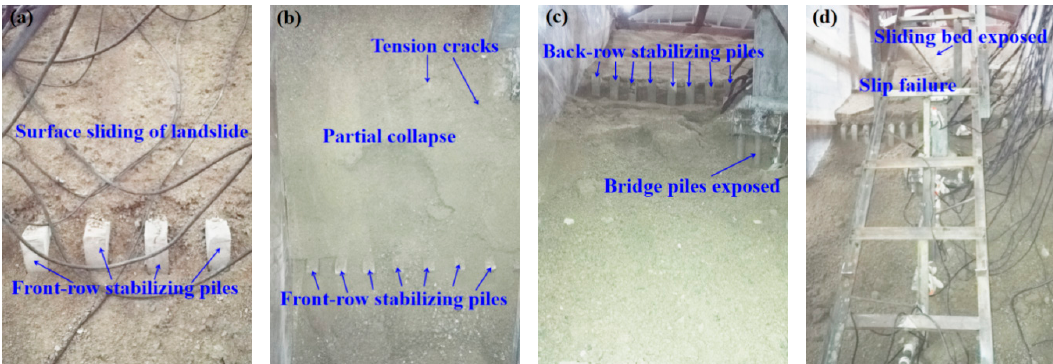
Figure 11. Development process of landslide under the action of vibration wave. ( a ) soil slip on the slope surface; ( b ) local failure of the slope body; ( c ) failure of the lower half of the sliding body; ( d ) the test model was completely destroyed.